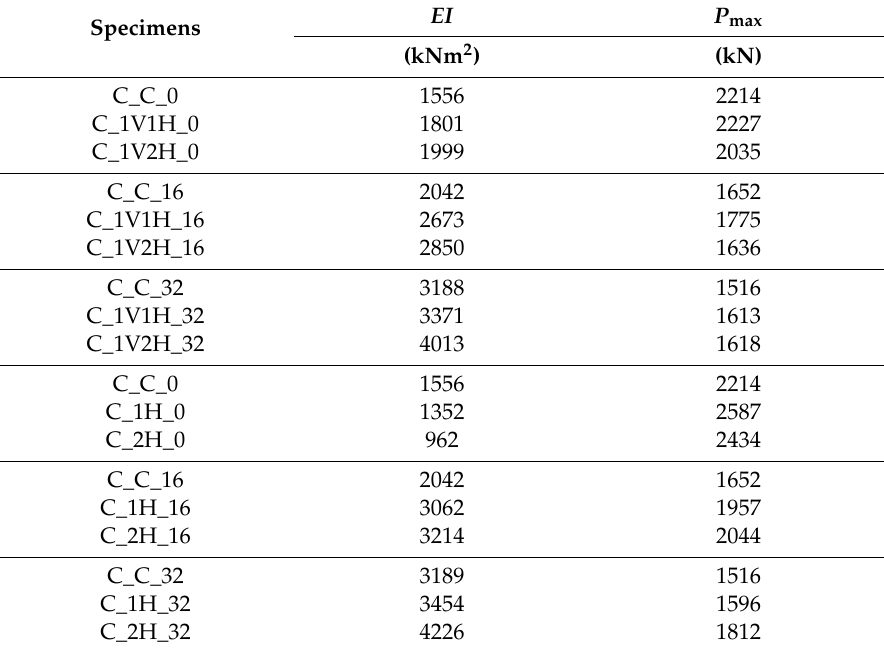
Table 5. Change in sti ff ness of columns C_1H, C_2H, C_1V1H, C_1V2H as a function of failure